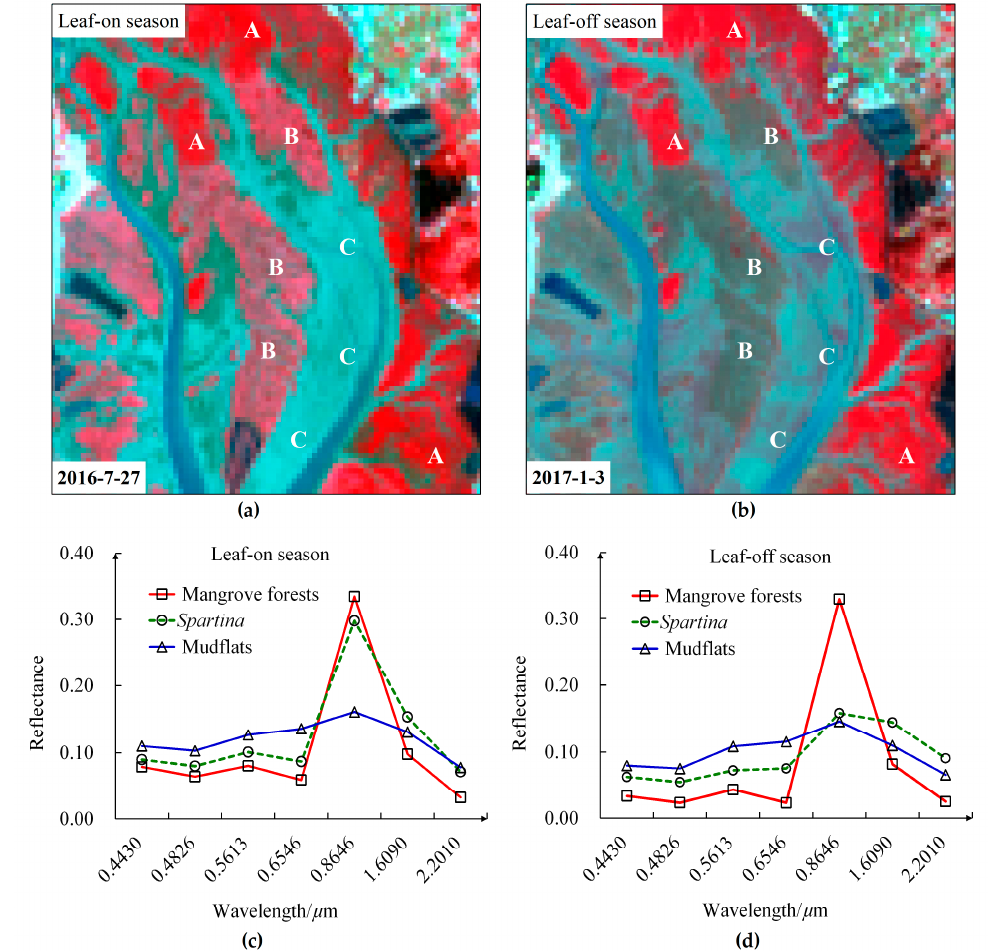
Figure 2. Comparisons of image characteristics and spectral reflectance for mangrove forests, Spartina , and mudflats in different seasons. ( a ) Image of leaf-on season; ( b ) image of leaf-off season; ( c ) spectral reflectance curve of leaf-on season for mangrove forests, Spartina , and mudflats; ( d ) spectral reflectance curve of leaf-off season for mangrove forests, Spartina , and mudflats (A: mangrove forests, B: Spartina , C: mudflats; Band combination Landsat OLI: R: G: B = Band 5: Band 4: Band 3).